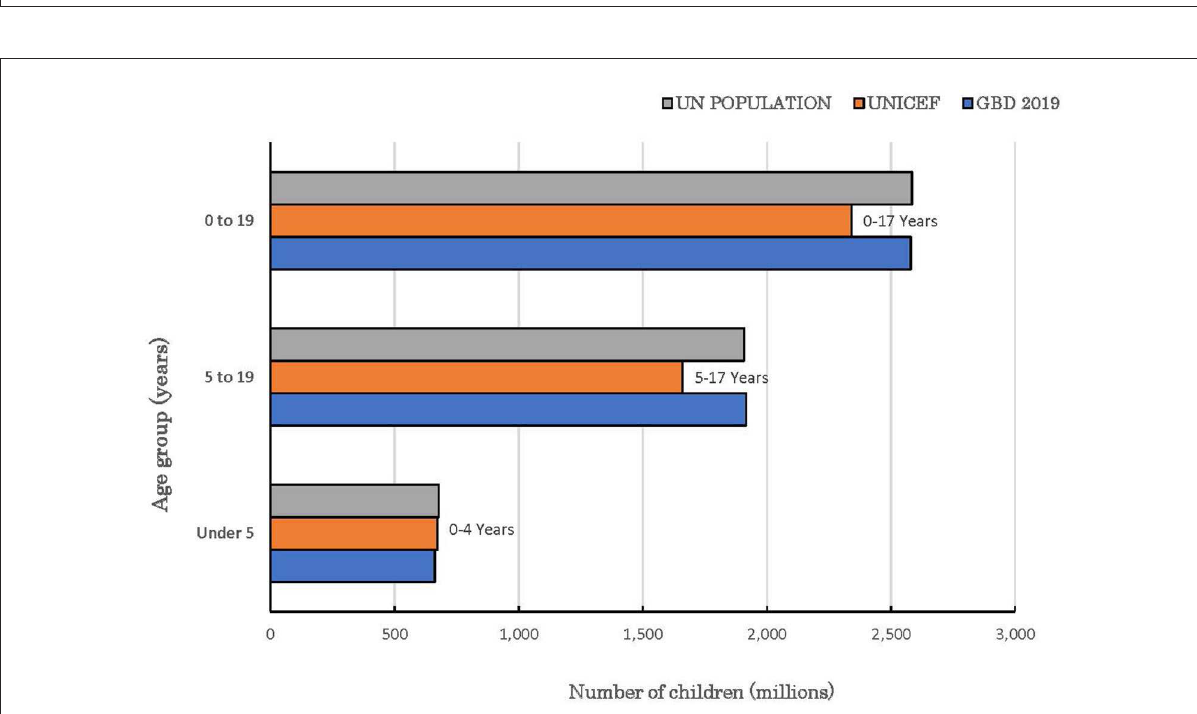
FIGURE4 Global population of children with and without disabilities in the reported age